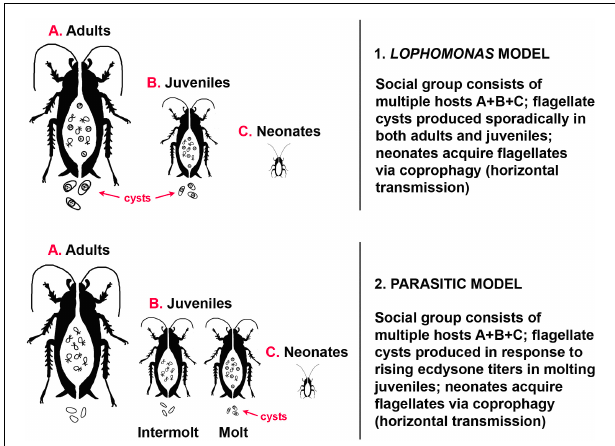
FIGURE 1 | Models of transmission dynamics in gregarious cockroaches. (1) Lophomonas model. Adults (A) do not molt, trophozoites and cysts are present in the gut, cysts are present in the feces. Trophozoites and cysts are present in the gut of molting and intermolt juveniles (B) , cysts are present in the feces. Neonates (C) hatch without protists in the gut. (2) Parasitic model. Adults (A) do not molt, trophozoites are present in the gut, no cysts are present in the feces. Trophozoites are present in the gut of intermolt juveniles (B) , no cysts in the feces; cysts are present in both the gut and feces of molting juveniles. Neonates (C) hatch without protists in the